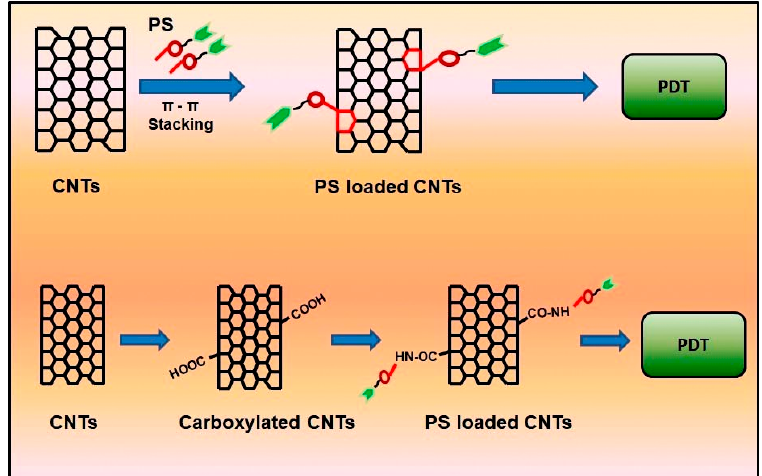
Figure 4. Loading mechanism of PS on nanomaterials. The attachment of the PS molecule on aromatic rings of CNTs by π – π stacking, and the carboxyl group into amide formation of PS on the walls of